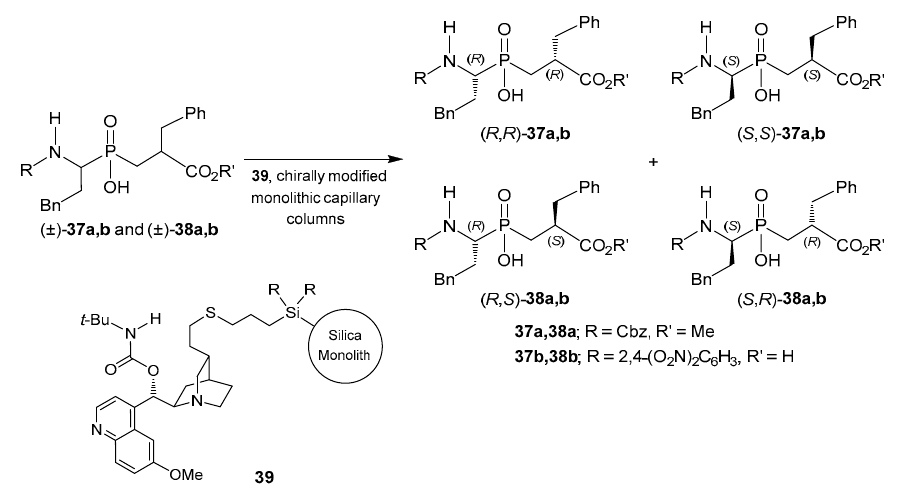
Scheme 22. Capillary electrochromatography (CEC) method for the separation of (±)- 37a , b and (±)- 38a , b .